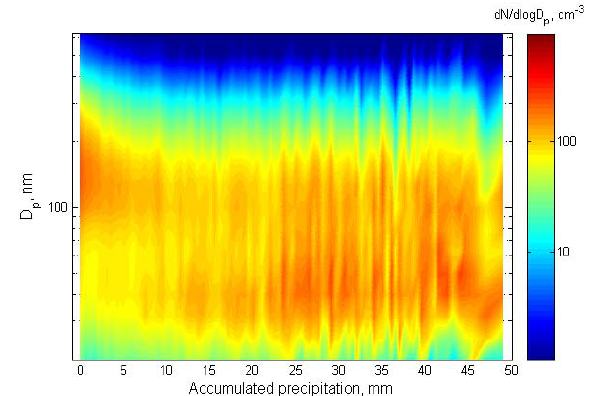
Fig. 18. Evolution of aerosol number size distribution as a function of accumulated precipitation (mm tot ) along 240 h trajectories for the sunlit period (March–September). Data from